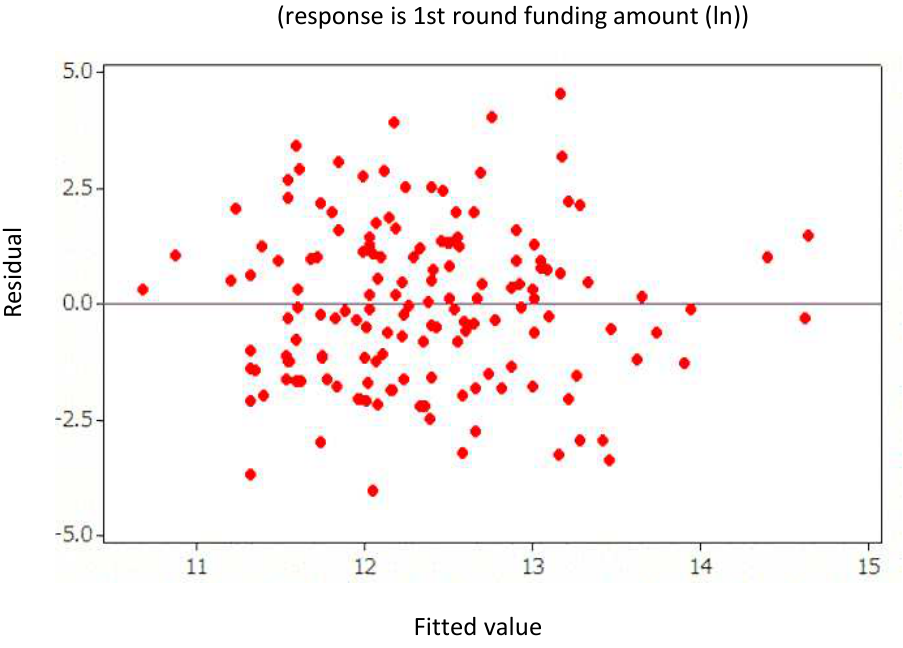
Fitted Figure 6. Residual vs fit plot for linear regression – first round funding amount vs human capital variables